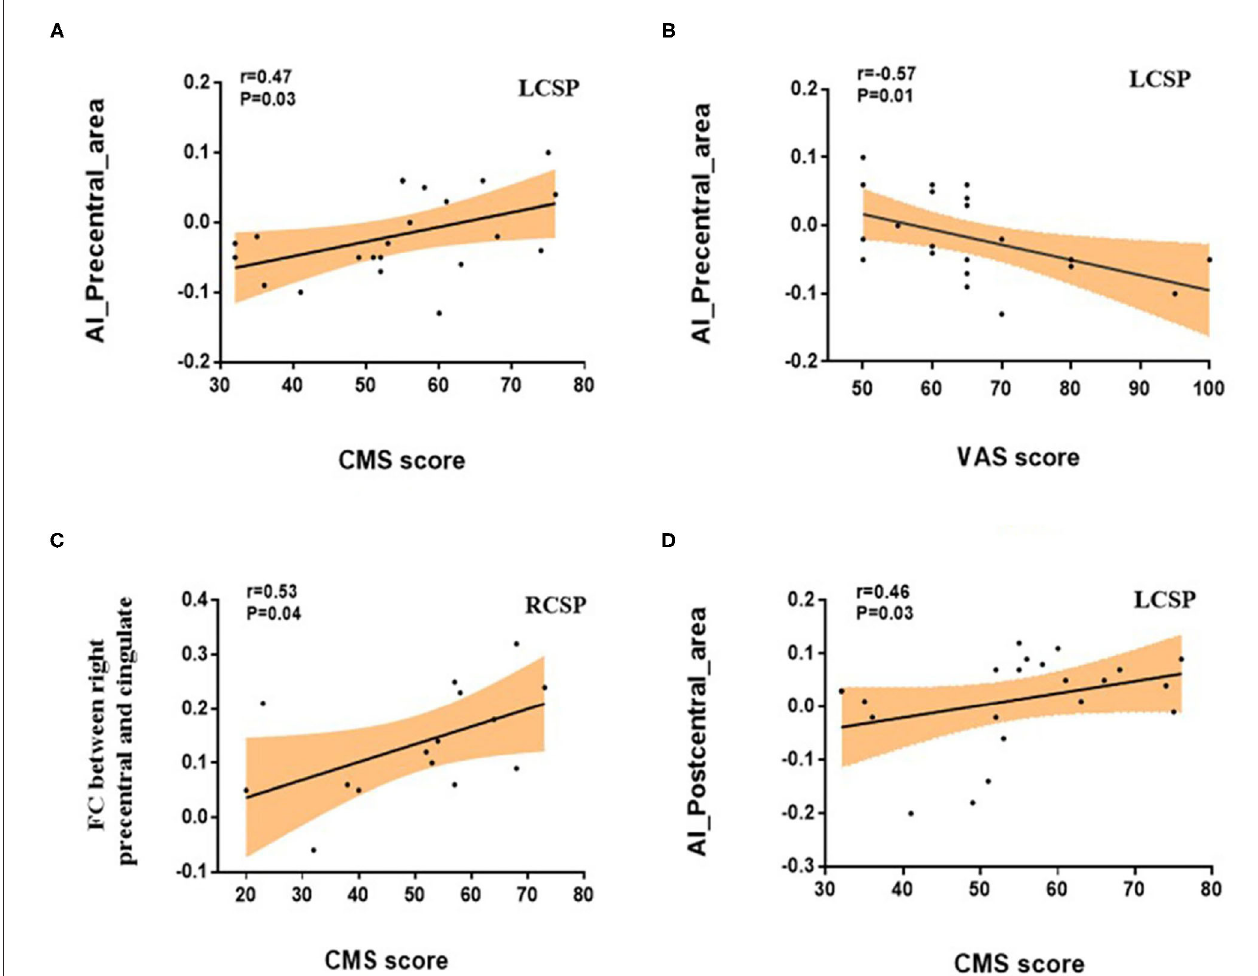
FIGURE 3 | Correlations between brain index and clinical variables in the patients with chronic shoulder pain (CSP). (A) Pearson’s correlation showed a positive association between the asymmetry index (AI) of precentral surface area and the CMS scores ( r = 0.47, p = 0.03). (B) Spearman’s correlation showed a negative association between the AI of precentral surface area and the VAS scores ( r = − 0.57 p = 0.01). (C) Pearson’s correlation showed that FC between right precentral gyrus and cingulate gyrus was significantly positively correlated with CMS ( r = 0.53, p = 0.04). (D) Spearman’s correlation showed a positive association between the AI of postcentral surface area and the CMS scores ( r = 0.46 p =